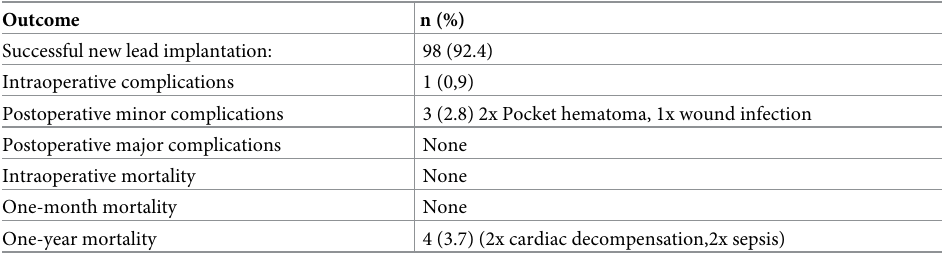
Table 3. Procedure